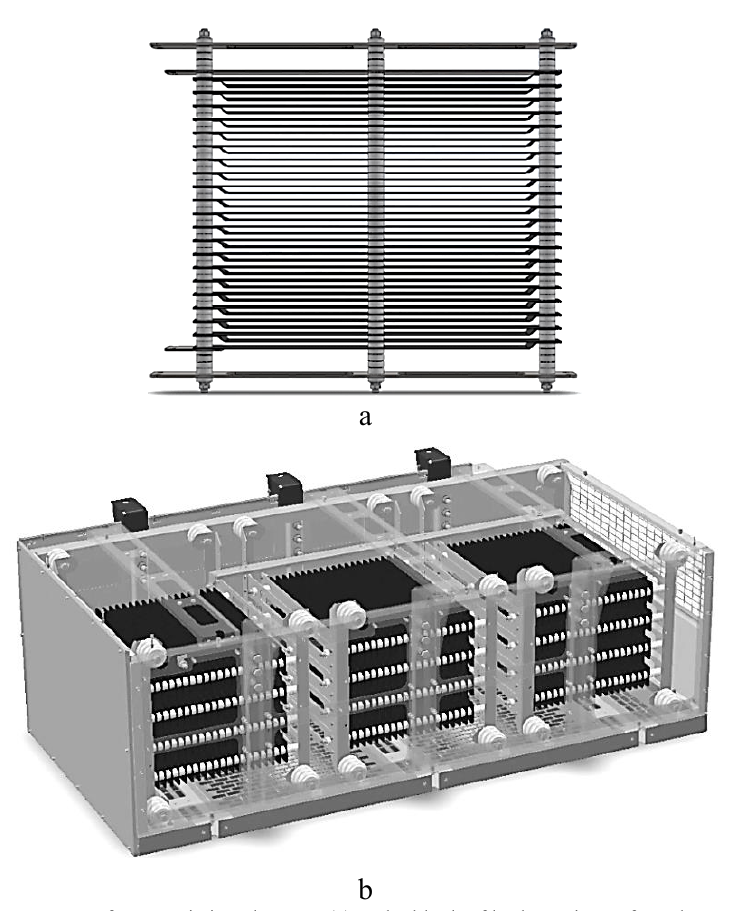
Fig. 1. Appearance of tape resistive elements (a) and a block of brake resistors for subway cars with open top and side walls